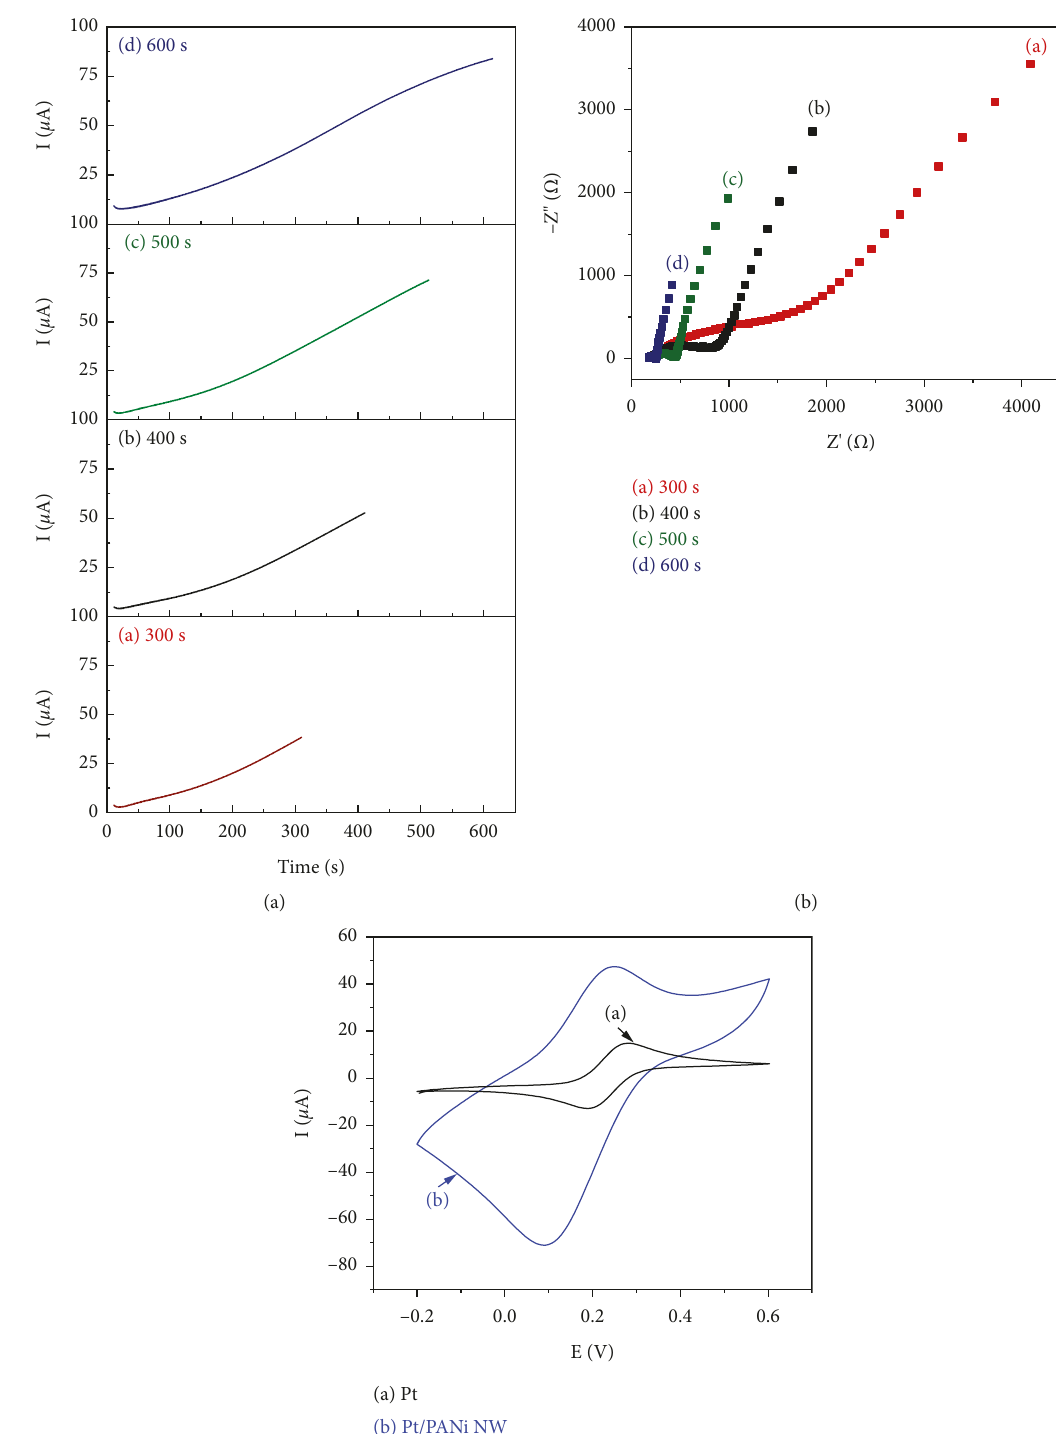
Figure 1: (a) Chronoamperometric curves during electropolymerization of PANi NWs on Pt WEs in 0.05M aniline and 0.5M H 2 SO 4 with different sets of time: (a) 300, (b) 400, (c) 500, and (d) 600 seconds; (b) EIS spectra (Nyquist plots) of Pt/PANi NW electrodes in which PANi NWs were electrosynthesized with different sets of time: (a) 300, (b) 400, (c) 500, and (d) 600 seconds; and (c) CV results of (a) Pt and (b) Pt/ PANi NW electrodes. Experimental conditions: EIS spectra were measured in K 3 Fe(CN) 6 /K 4 Fe(CN) 6 (0.005M) and 0.1M KCl solution, 5mV, and E DC 160mV; CV measurements were conducted at a scan rate of 50mVs − 1 in frequency range: 100kHz–100mHz, E AC (cid:29) (cid:29) K 3 Fe(CN) 6 /K 4 Fe(CN) 6 (0.005M) and 0.1M KCl